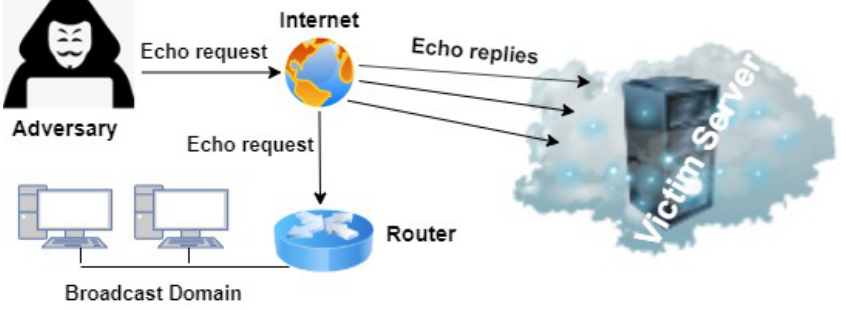
Figure 2. The topology of smurf attack.